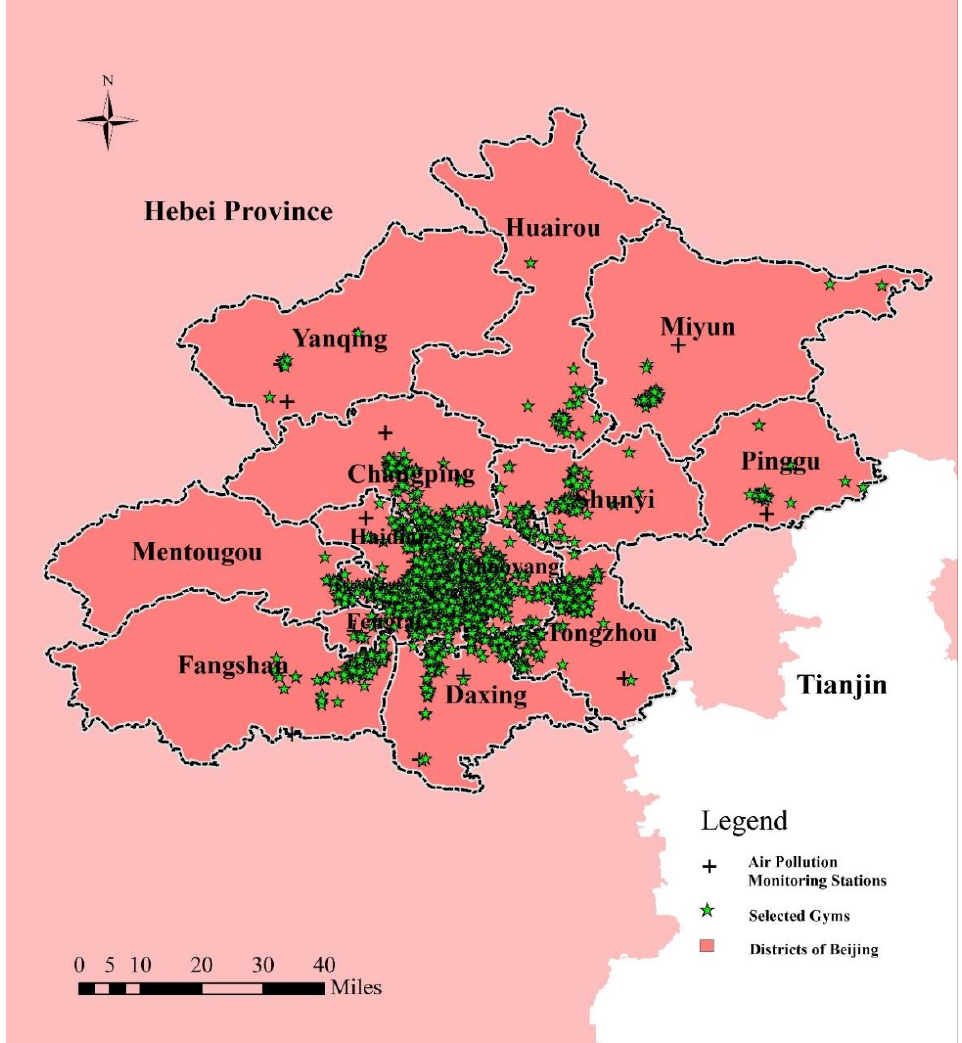
Figure 2. Study area. The spatial distribution of 2452 gyms of 16 administrative districts are indicated in Beijing, China.